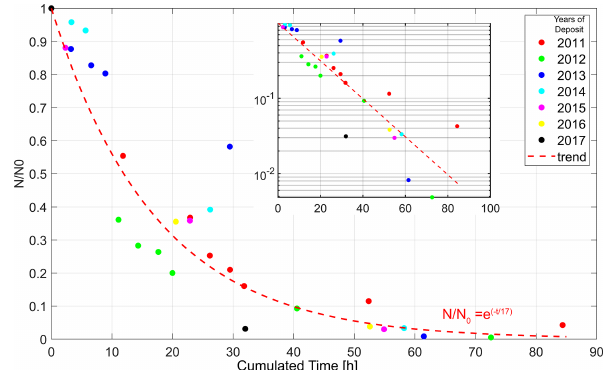
Figure 7. Population of boulders, normalized to its initial size, as a function of the cumulative effective transport time, calculated for a threshold discharge of 45m 3 h − 1 . The seven populations of boul- ders that we monitor are plotted using different colors, as indicated on the plot. Red curve: fit of the data by Eq. (3) (exponential decay) with a residence time of 17h (half-life of 12h). Inset: same plot with semi-logarithmic